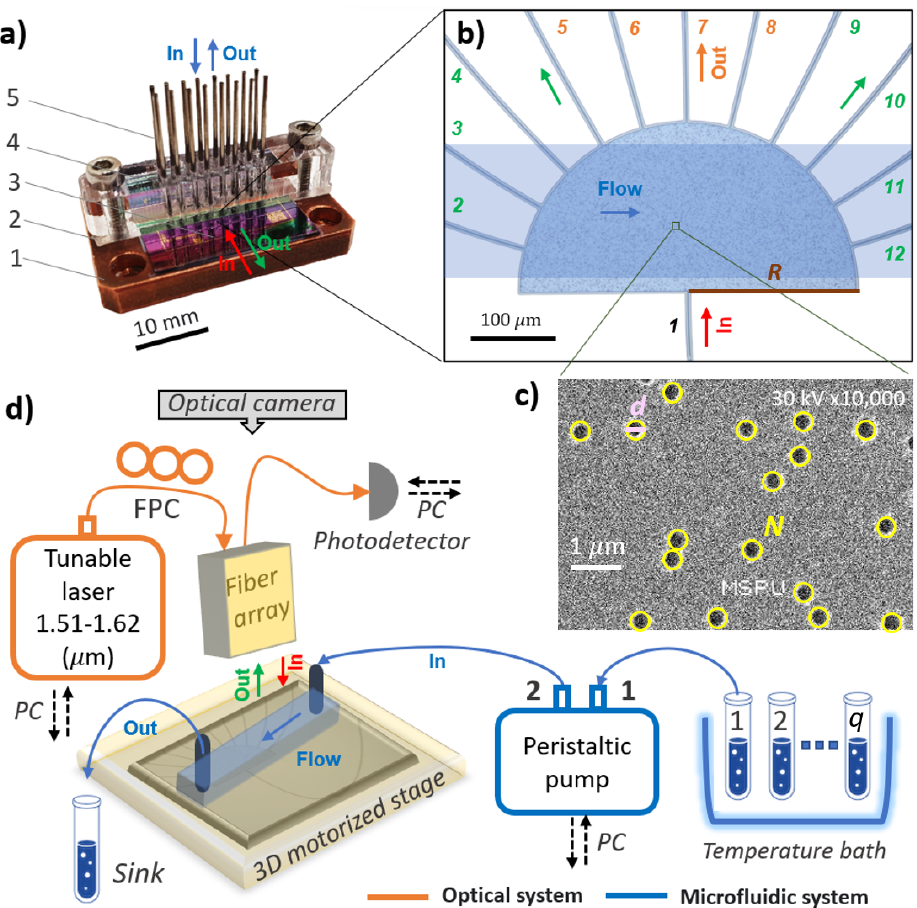
Figure 1. ( a ) Image of the microfluidic nanophotonic sensor: 1—copper support of the chip, 2—PDMS with formed MFCs, 3—nanophotonic chip, 4—plastic holder, and 5—fluid tubes. ( b ) Optical image of random spectrometer without background. The orange color for output channels represents the ballistic regime of propagation for optical radiation, and the green color represents the diffusive regime; R is the random spectrometer radius. ( c ) The image of holes obtained by using an electron microscope; d is the hole diameter; N is the hole quantity. ( d ) Schematic view of the experimental setup: PC—personal computer, FPC—fiber polarization controller, 1 2 ... q —different concentrations of isopropanol in DI